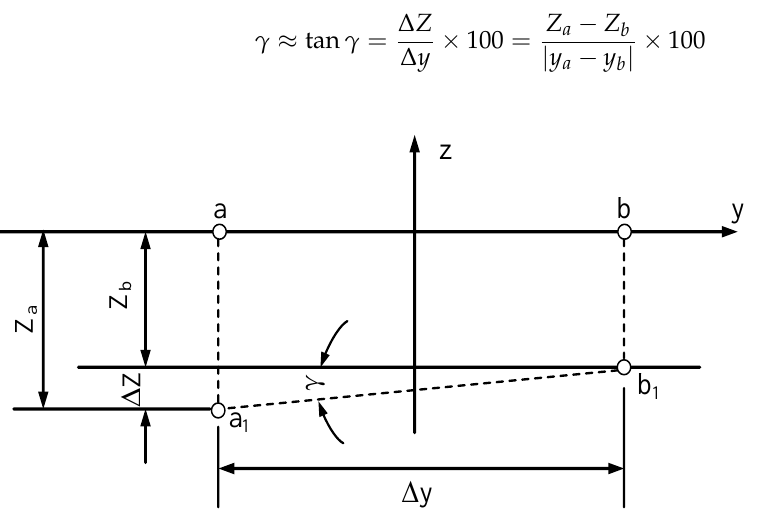
Figure 13. Schematic diagram of deformation gradient method.